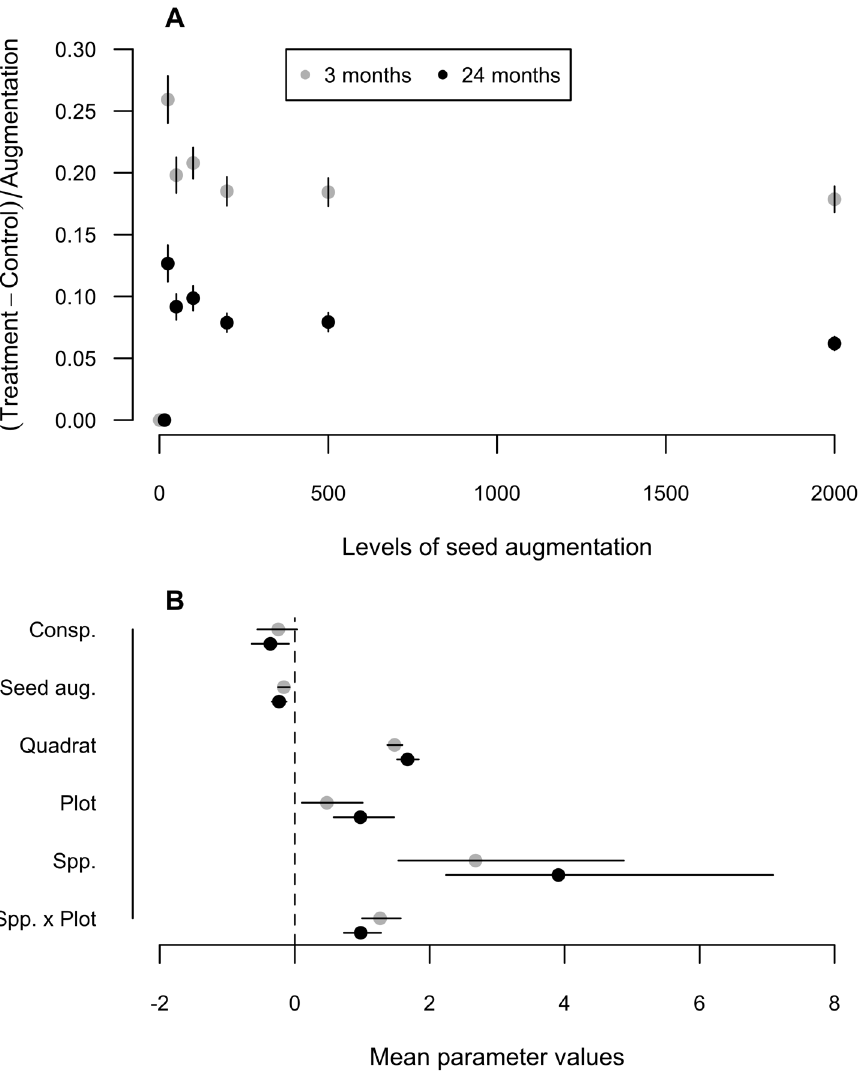
Figure 1. Per-seed recruitment varies across seed augmentation levels and with environmental variation. (A) Per-seed recruitment effect size E (realized seed and establishment limitation) varies between 0 and 1, with 1 representing complete seed limitation and 0 representing complete establishment limitation. These relatively low effect sizes ( E v 0 : 5 ) indicate that this natural forest system is more strongly establishment- limited than seed-limited. Error bars are 95% confidence intervals. (B) Results from generalized linear mixed models (GLMM) of per seed recruitment, E , as a function of the seed addition level (Seed aug.) and the density of conspecific trees (Conspecifics) at three and 24 months after seed augmentation. Error bars are the 2.5% and 97.5% credible intervals. Random effects include individual quadrats (Quadrat), the vegetation plot (Plot), the species identification (Species), and species-by-plot interaction (Species 6 Plot). The significant species-by-plot interactions at both time intervals strongly refute the equivalence of species across a heterogeneous landscape, thereby supporting a niche-based perspective of